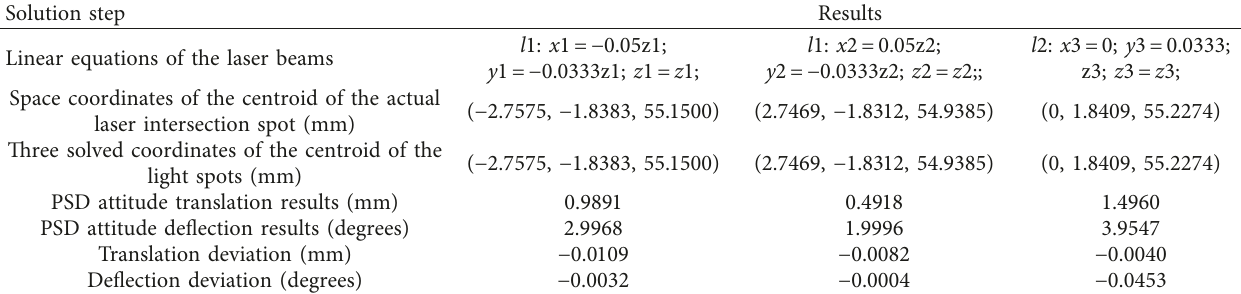
Table 3: Simulation results.